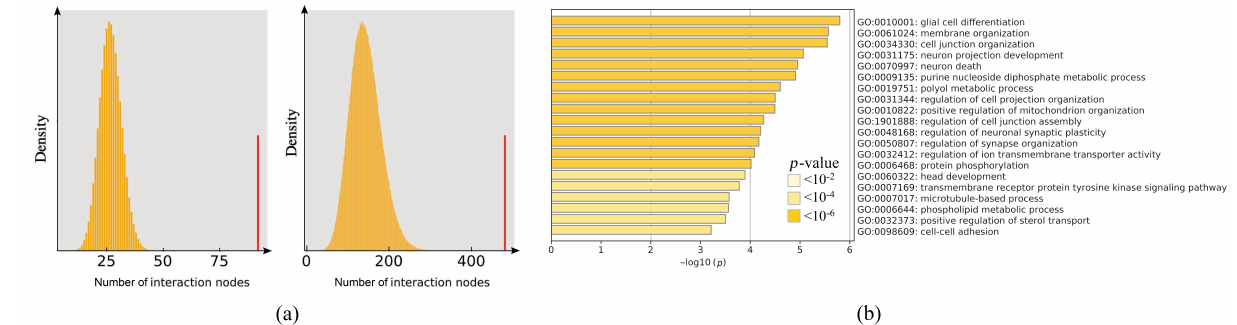
Fig. 5 The differential IR events predicted by DeepRetention are evaluated for biological significance. (a) The parent genes of differential IRs on the BBUKY dataset show significant functional associations with known AD-associated genes in the ADBrainNexus network (The p -values for both interaction genes and edges are less than 1.0 (cid:2)(cid:2)(cid:2) 10 (cid:0) (cid:0) (cid:0) 6 ). In the figure, the red line represents the number of interactions between the parent genes of differential IRs and known AD-associated genes. The yellow bar chart represents the number of interaction pairs between randomly selected genes and known AD-associated genes. (b) The result of the GO enrichment on the BBUKY dataset. The parent genes of differential IRs predicted by DeepRetention are used as the input for GO enrichment in the biological processes. The enrichment analysis is performed by Metascape using the default